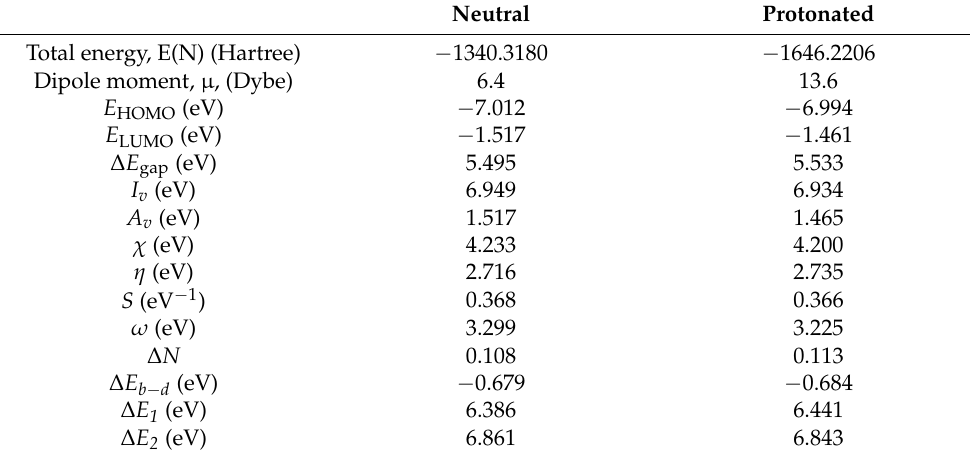
Table 6. Various DFT parameters for the epoxy resin (neutral and protonated